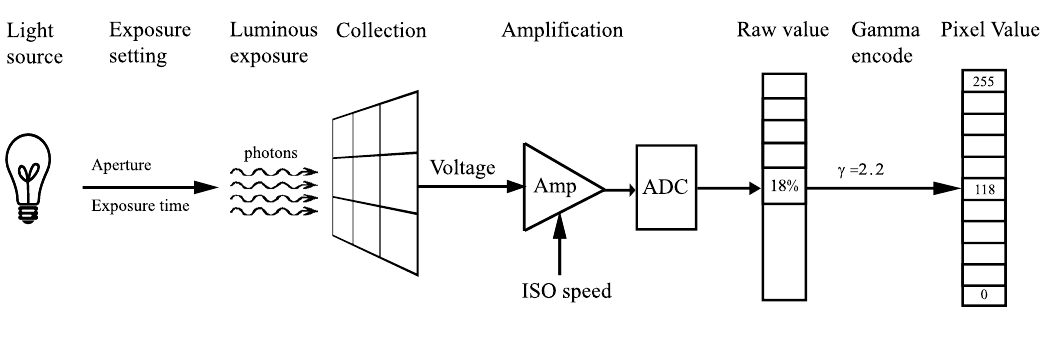
Figure 3. The whole process for calculating the pixel